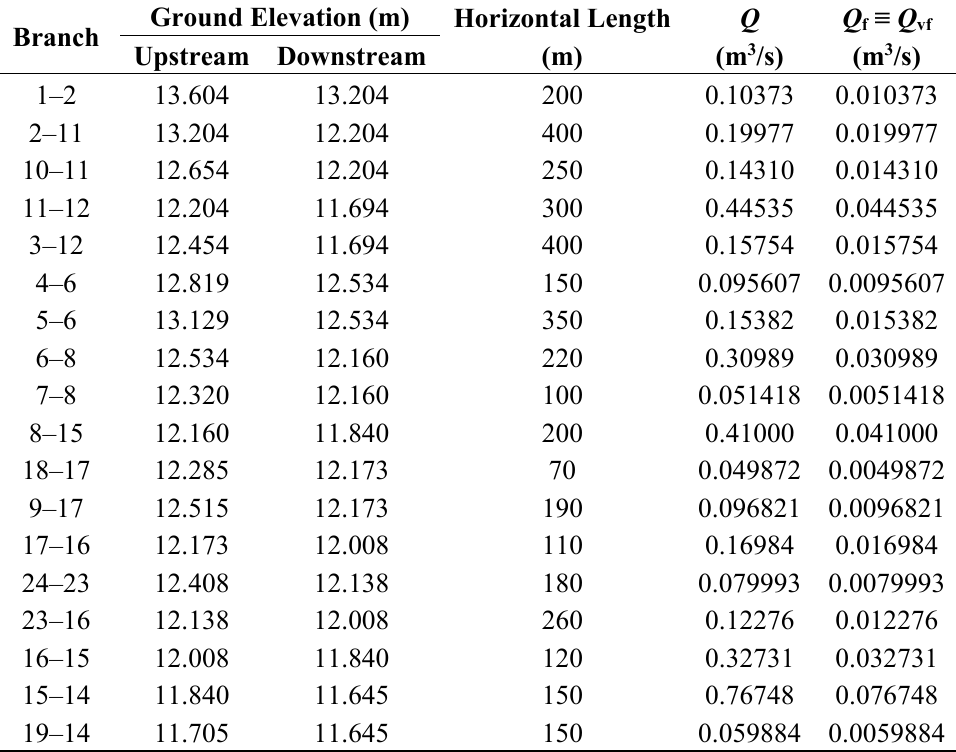
Figure 3. Biggiero and Pianese (1996) [64] case study. Layout. Table 5. Biggiero and Pianese (1996) [64] case study. Geometric and hydraulic characteristics of the